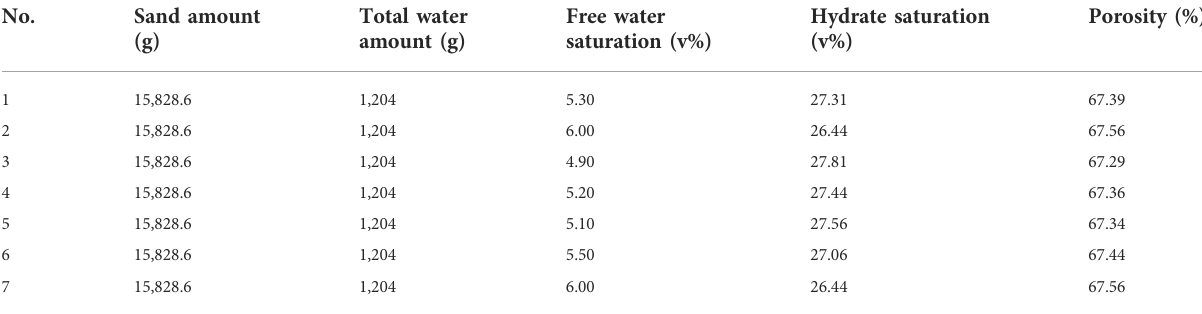
TABLE 2 The hydrate formation conditions of seven experiments. No.